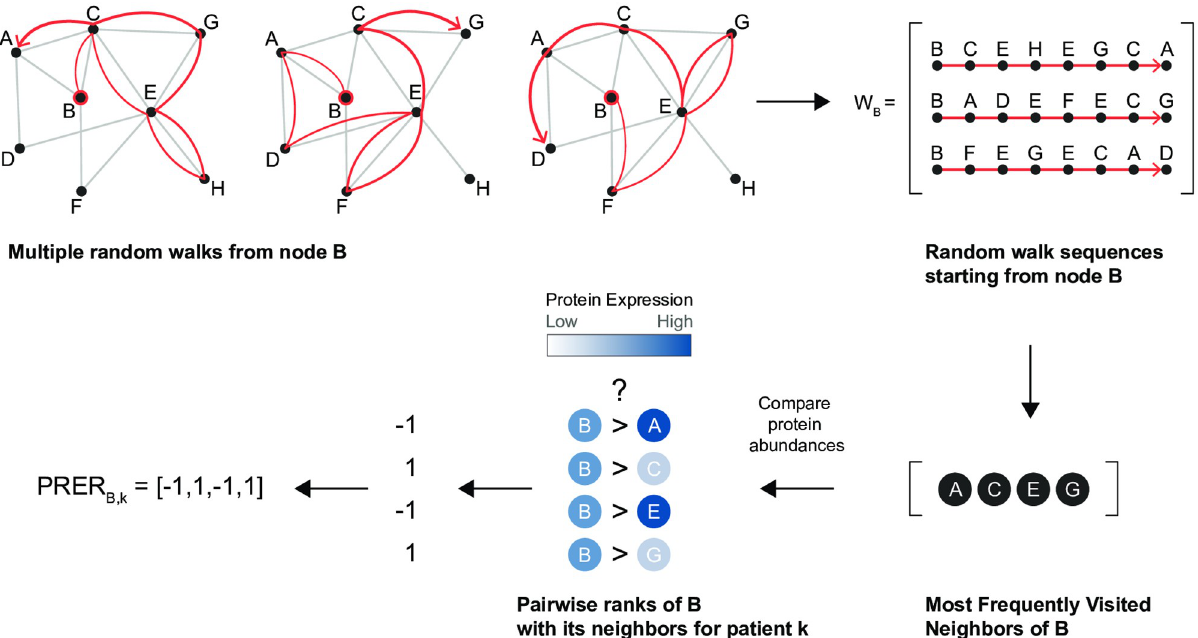
Fig 1. Illustration to show how the PRER representation is obtained for a single source node, node B. The nodes in the graph are proteins, edges exist if they interact in the PPI network. First, several random walks are generated that starts at node B as in [17]. These random walks are stored in W B and used to define the neighborhood of B , N . Only the most frequently visited nodes are included in the set of neighbors of B. Then, the pairwise B comparison of the neighborhood proteins in terms of their protein expression quantities is used to form a representation of the patient for node B and its neighborhood. The figure shows the features generated for a single protein. This procedure is repeated for all source proteins, and the resulting vectors are concatenated.